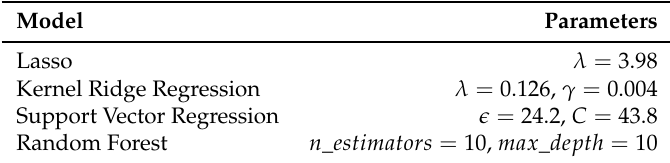
Table A3. Optimized model parameters from training